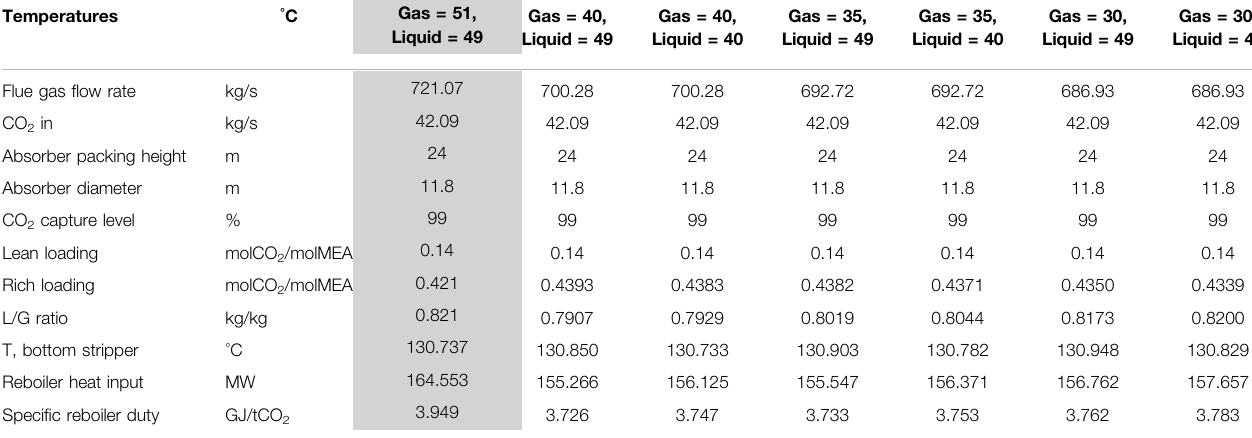
TABLE 5 | Resultsforreducedinlet-to-the-absorbertemperaturesfor99%CO 2 captureandleanloadingof0.14molCO 2 /molMEA(theshadedcolumnreferstothebasecase).